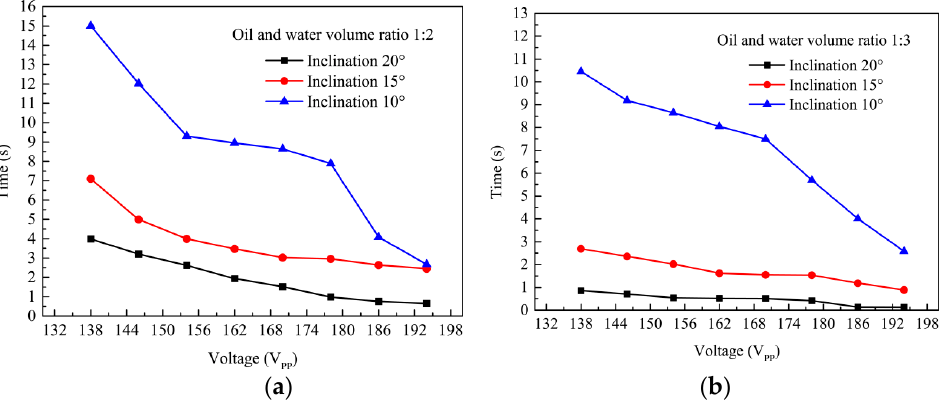
Figure 5. The input power effects on the oil/water mixed drop separation time. ( a ) The relationship between the oil/water mixture separation time and input power (VPP) with the oil/water volume ratio 1:2 on the different inclination angles of mirror substrate. ( b ) The relationship between the oil/water mixture separation time and input power (VPP) with the oil/water volume ratio 1:3 on the different inclination angles of mirror substrate. Reproduced from Ref. [96].